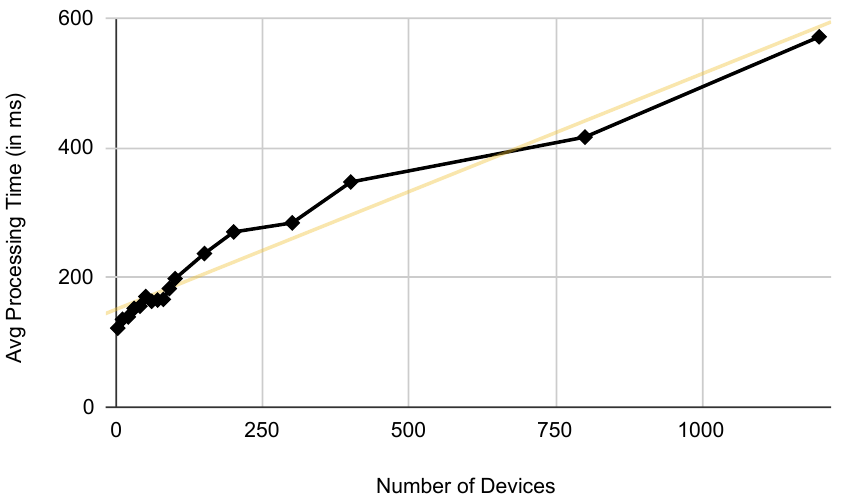
Figure 4. The graph displays the average processing time (in milliseconds) for a number of devices that ranges from 2 to